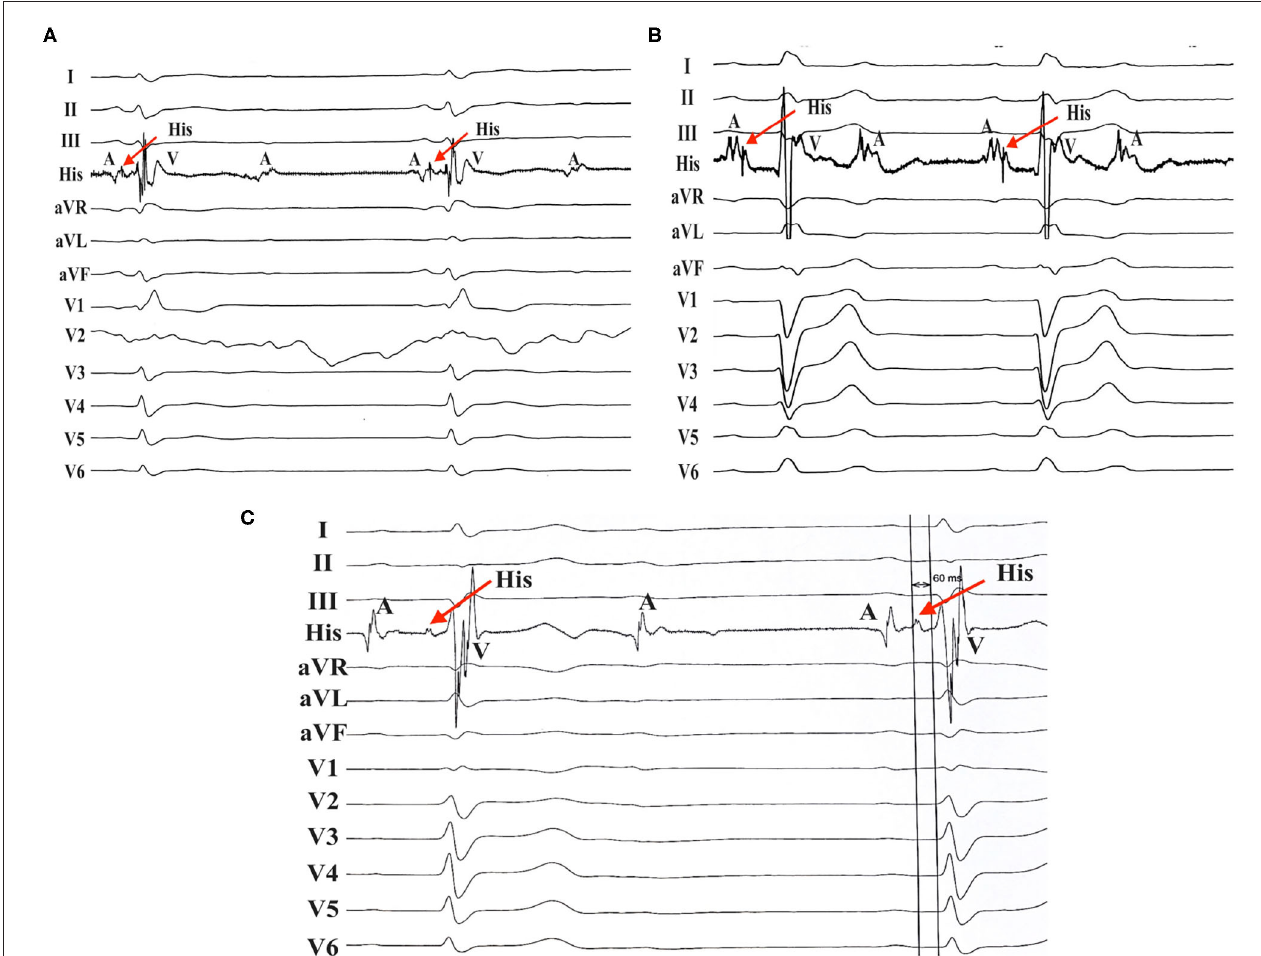
FIGURE 1 | AV nodal block in patients with RBBB/LBBB. (A) Patient no. 8 with RBBB developed AV nodal block. (B) AV nodal block was found in patient no. 13 with LBBB. (C) Patient no. 17 with RBBB also developed AV nodal block with an His-ventricular (HV) interval of 60ms. AV, atrioventricular; RBBB, right bundle branch block; LBBB, left bundle branch